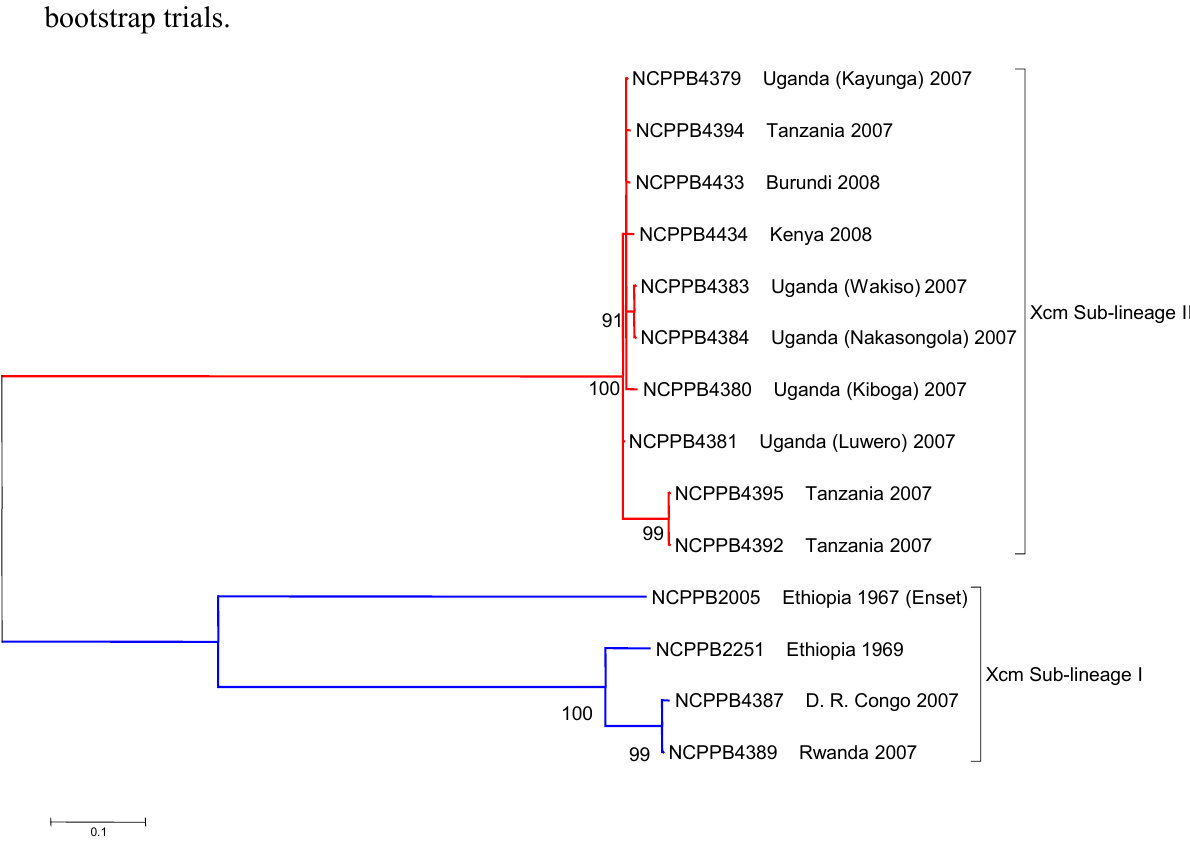
Table 3. Examples of non-silent single-nucleotide polymorphisms that distinguish